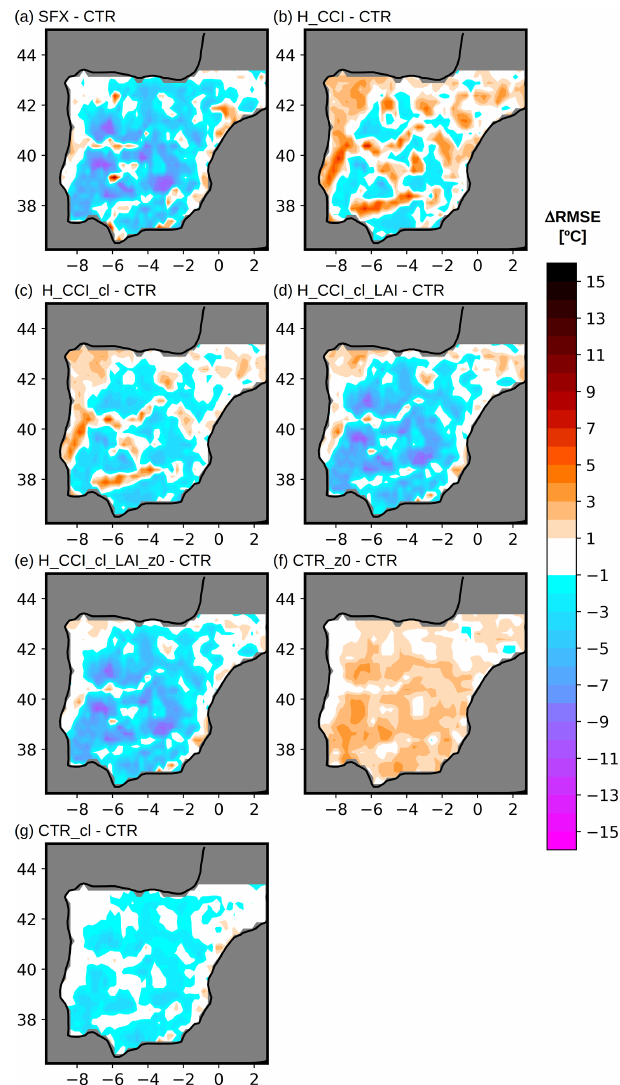
Figure 9. Difference in RMSE computed for daily maximum LST over Iberia in (a) SFX minus CTR, (b) H_CCI minus CTR, (c) H_CCI_cl minus CTR, (d) H_CCI_cl_LAI minus CTR, (e) H_CCI_cl_LAI_z0 (same as H_CCI_cl_LAI but with z0h re- duced by a factor of 10) minus CTR, (f) CTR_z0 (same as CTR but with z0h reduced by a factor of 10) minus CTR, and (g) CTR_cl (same as CTR but with clumping parameterization for high and low vegetation) minus